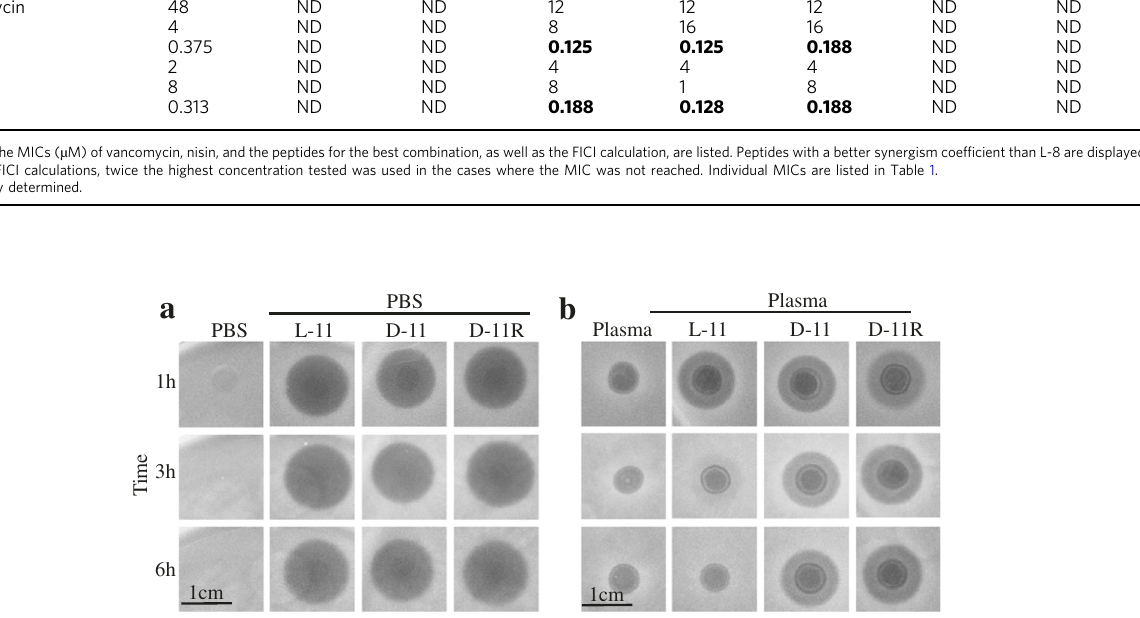
Fig. 1 Plasma stability for the peptides L-11, D-11 and D-11R. a Antimicrobial activity of the peptides L-11, D-11, and D-11R against K. pneumoniae LMG 20218 after their incubation in PBS. b Antimicrobial activity of the peptides L-11, D-11, and D-11R after their incubation in human